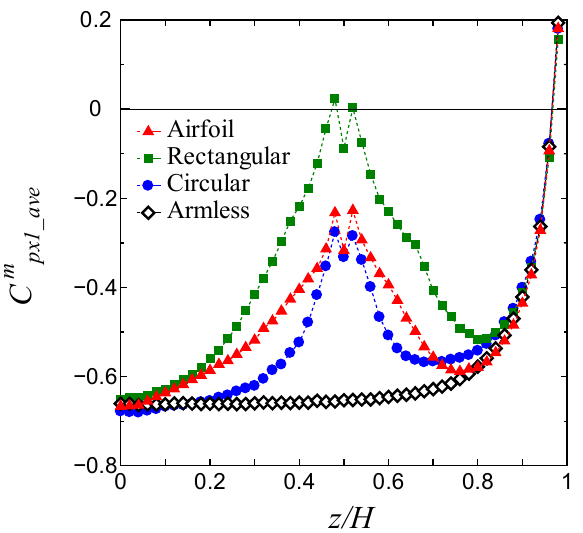
Figure 15. Distribution of the x 1 -direction pressure-based force coefficients on each half-blade. The data at the respective span position were averaged over the seventh rotor-revolution using Equation (9).